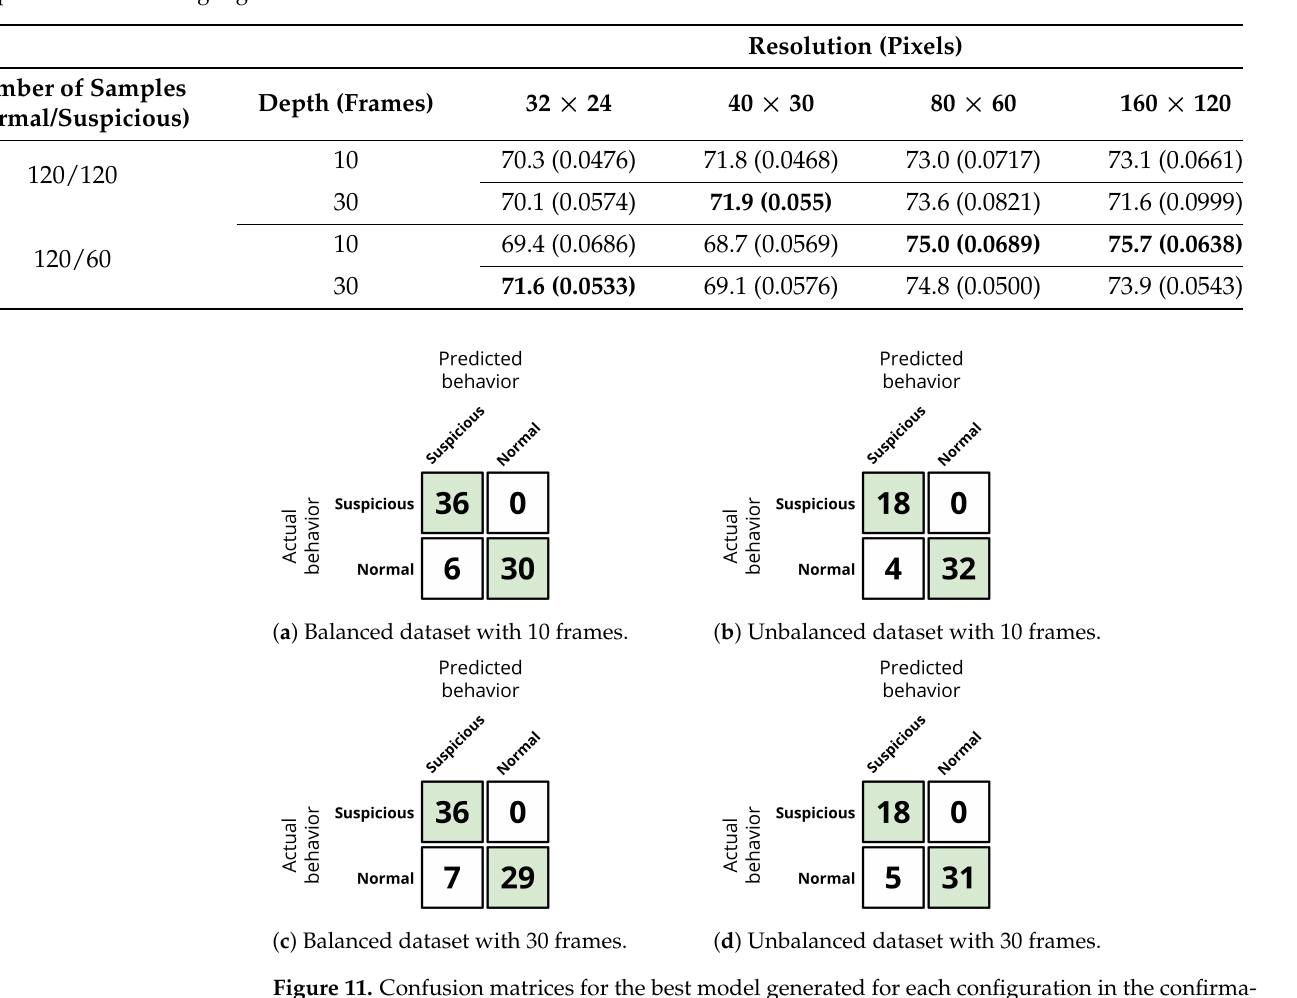
Table 9. Accuracy (%) of the models trained with the 16 different configurations from the confirmatory experiment. Each cell presents the average accuracy of 30 independent models per configuration and its standard deviation. The best results per resolution are highlighted in bold.